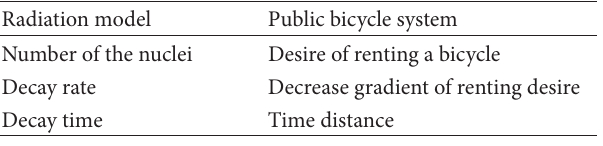
Table 4: The relationship between public bicycle system and radiation model.